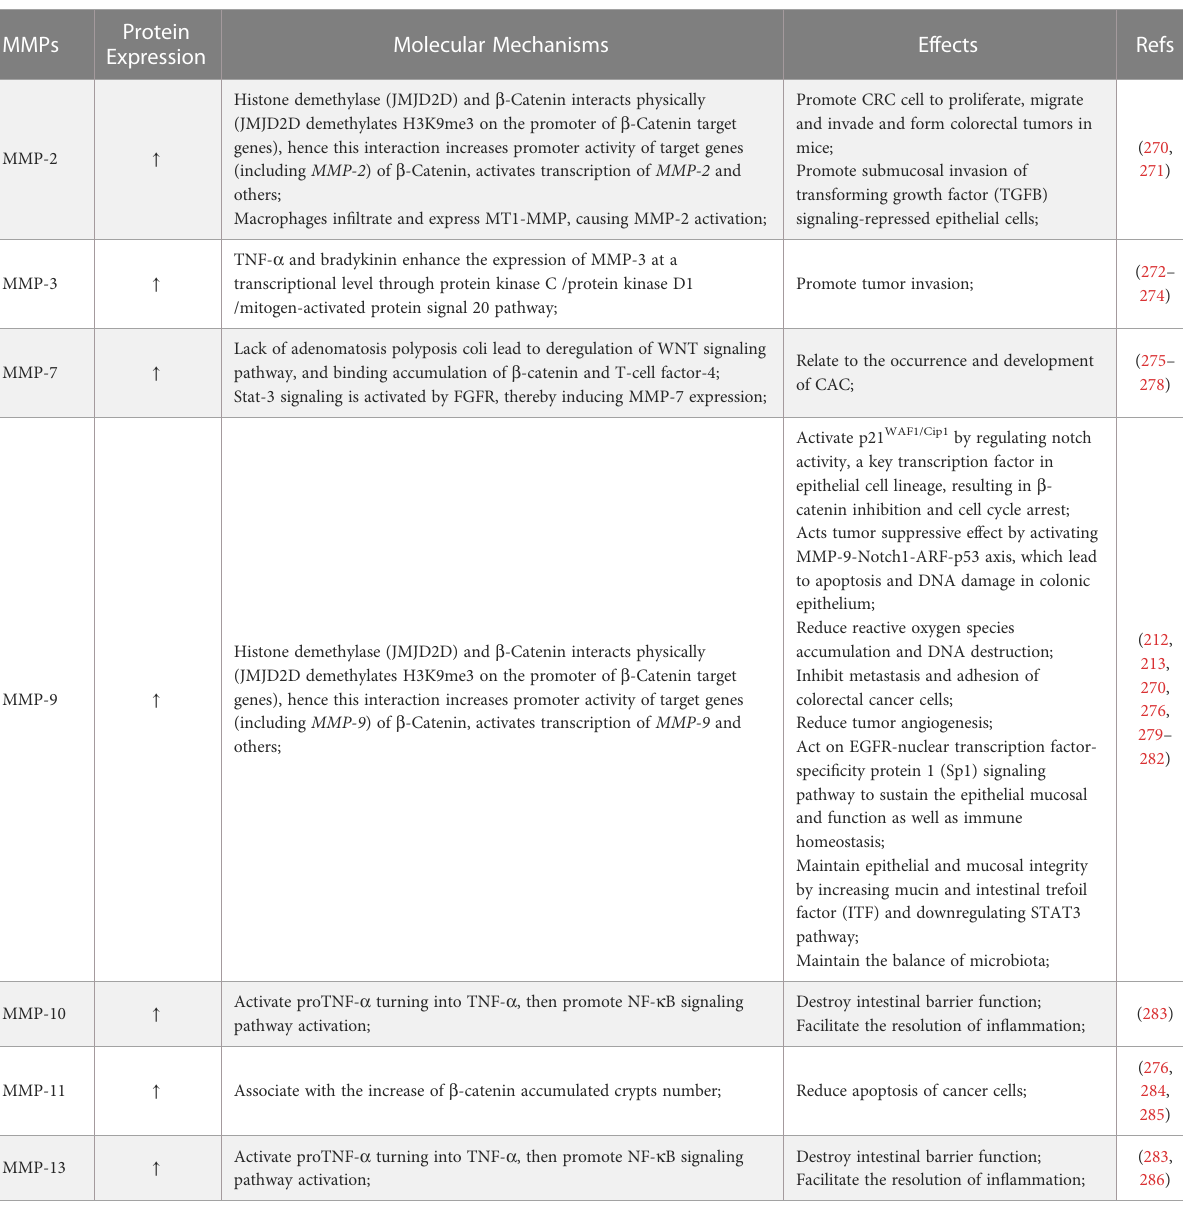
TABLE 2 The key matrix metalloproteinases (MMPs) in colitis associated